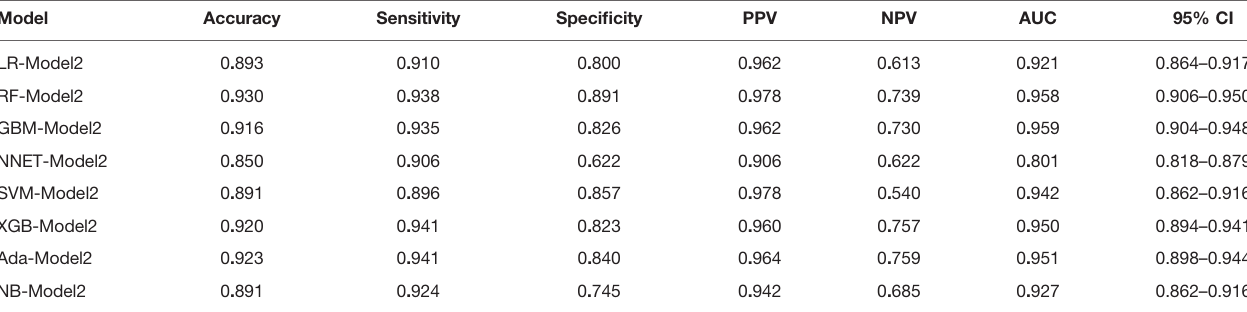
TABLE 3 | Prediction performance of Model2 in the testing